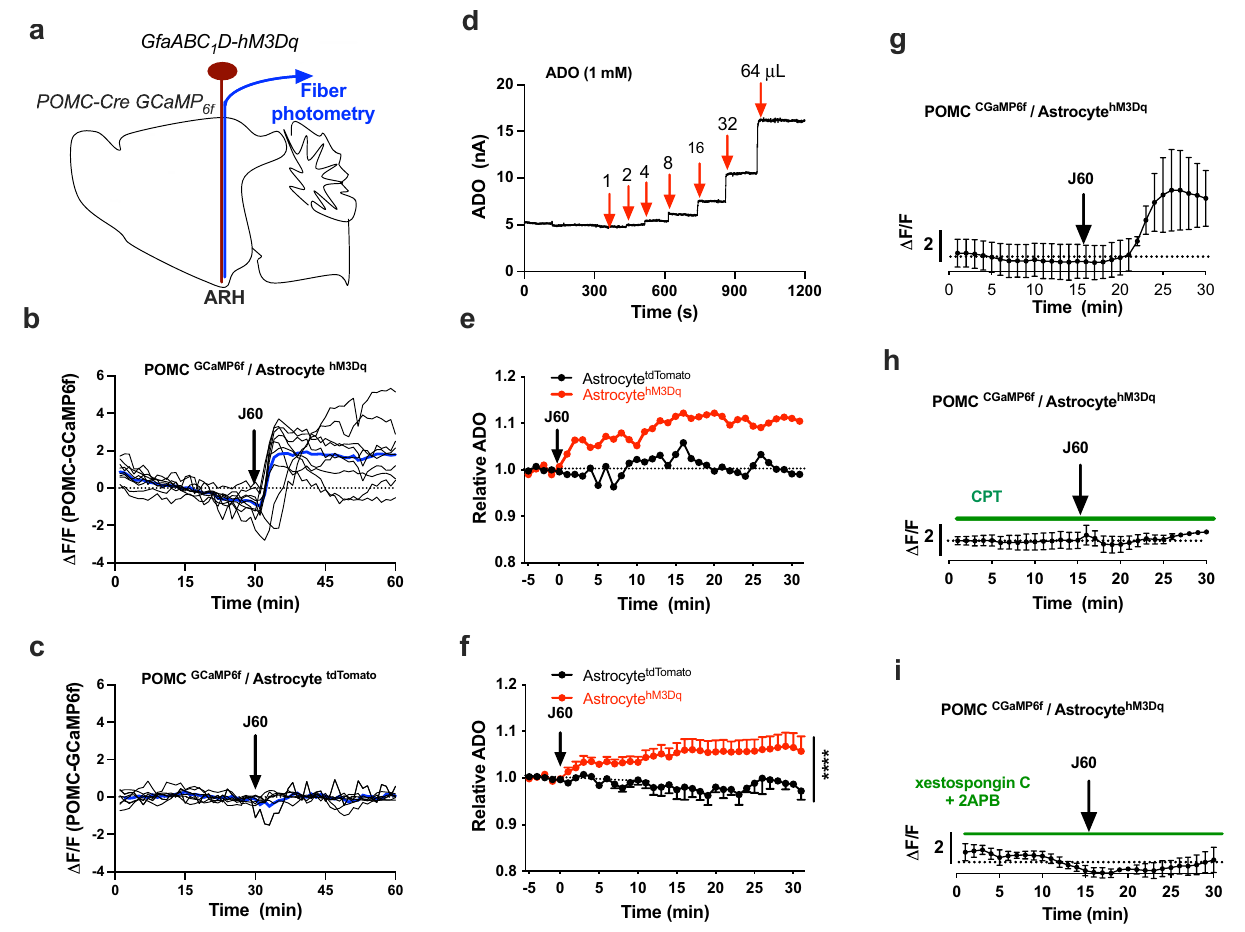
Fig.7|AstrocytestimulationexcitesPOMCneuronsandelevatedextracellular ADO. a Schematic illustration of targeting a vector carrying GfaABC 1 D-hM3Dq to ARHandimplantingaphotometry fi beroverARHindualPOMC-CreGCaMP 6f mice. b , c Individual photometry traces showing that astrocyte stimulation with J60 via i.p. increased the intensity of POMC neuron GCaMP 6f signals in the astrocyte b hM3D-transducedmice( n =8)comparedto c tdTomato-transducedmice( n =6). Thebluelinerepresentstheaverageoftheindividuallines. d ADOprobecalibration curve using increased volumes of ADO (1mM) following the detailed instructions fortheprobes. e Representativetracesofreal-timerecordingofthesignalsofADO